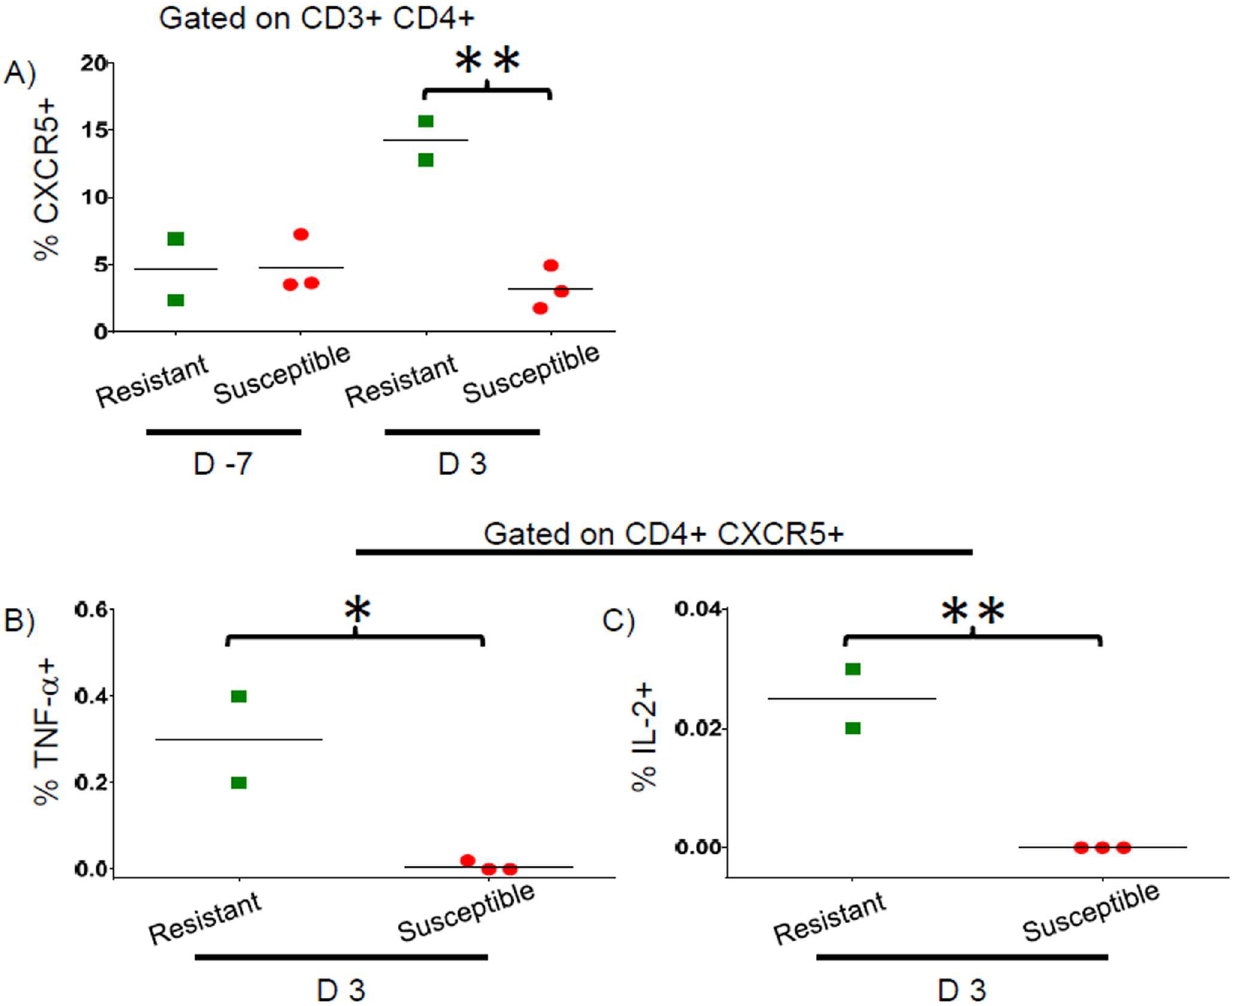
Fig 4. Percentage of pT fh and cytokine production by pT fh in Resistant and Susceptible volunteers. A) Live single cell CD14-CD19- events were gated on CD3, followedby gating for CD4 and then CXCR5. The percentageof CD4 cells positive for CXCR5 is indicatedat baseline(D -7) and 3 days post challenge (D 3). B) Net CFA/I-specific TNF- α production above pre-challenge(D -7) by CD4+ CXCR5+ (pT fh ) on day 3 post-challenge (D3). C) Net CFA/I-specific IL-2 production above pre-challenge(D -7) levels by CD4+ CXCR5+(pT fh ) on day 3 post- challenge (D3). * p < 0.05 ** p <